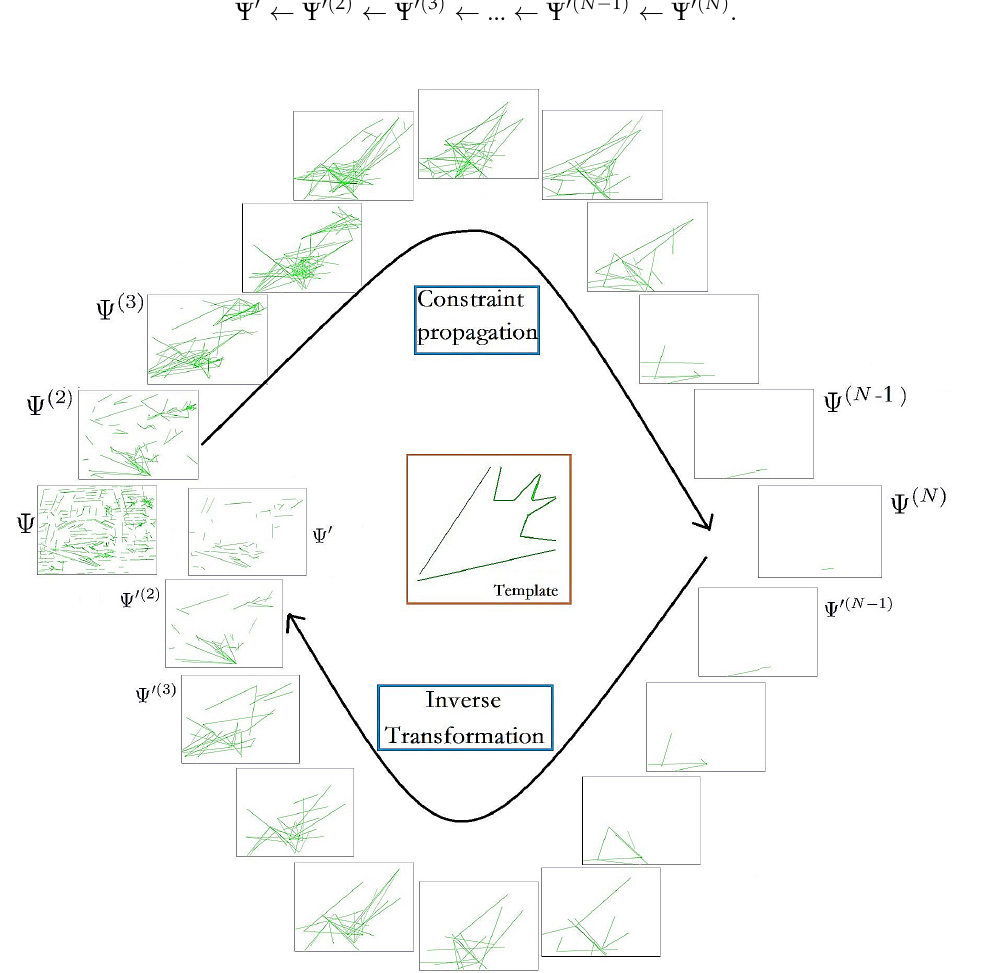
Figure 5. Example of the process of constraint propagation. For a shape-based template consisting of N lines, there are N layers of constraints Γ 1 ∼ Γ N . In the first layer, the lines that satisfy the constraints in the first layer are merged into new lines in the second layer. Similarly, the lines that satisfy the constraints are merged into new lines in the next layer. As the layer number increases, the number of lines decreases. Therefore, this indicates that the lines satisfying the constraints can be extracted. For each geometric constraint in Γ 1 , a corresponding candidate set of η pairs of lines could be found. In this candidate set, each pair of lines was merged into a new line in Ψ ( 2 ) . Similarly, N layers of candidate sets of lines